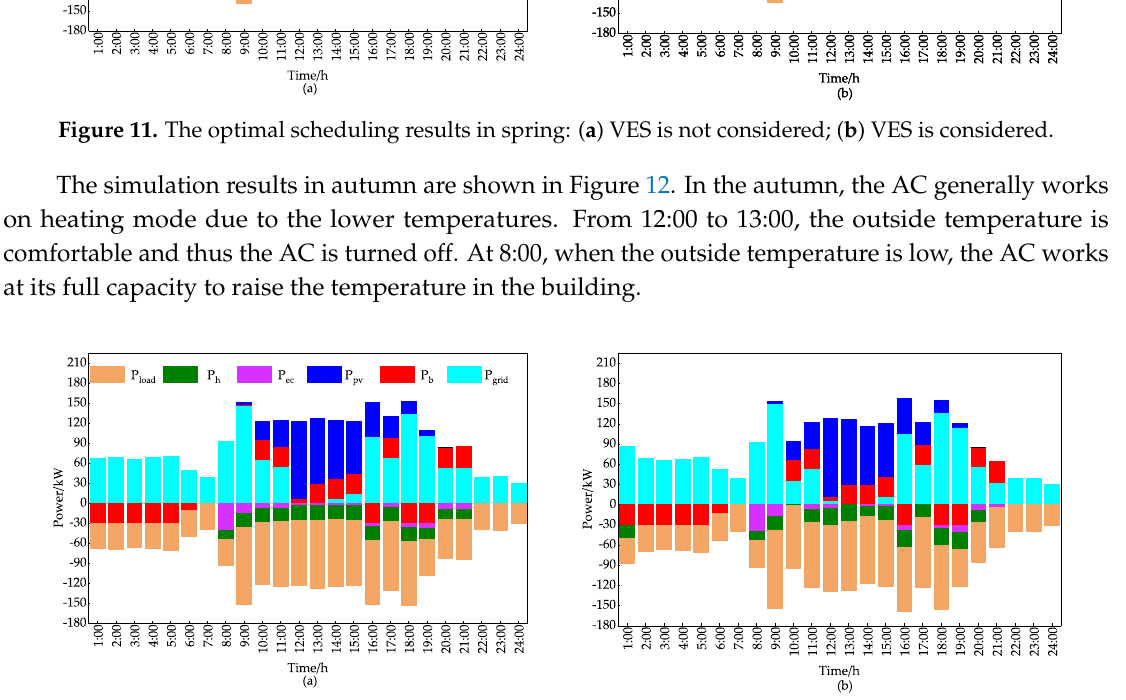
Figure 12. The optimal scheduling results in autumn: ( a ) VES is not considered; ( b ) VES is